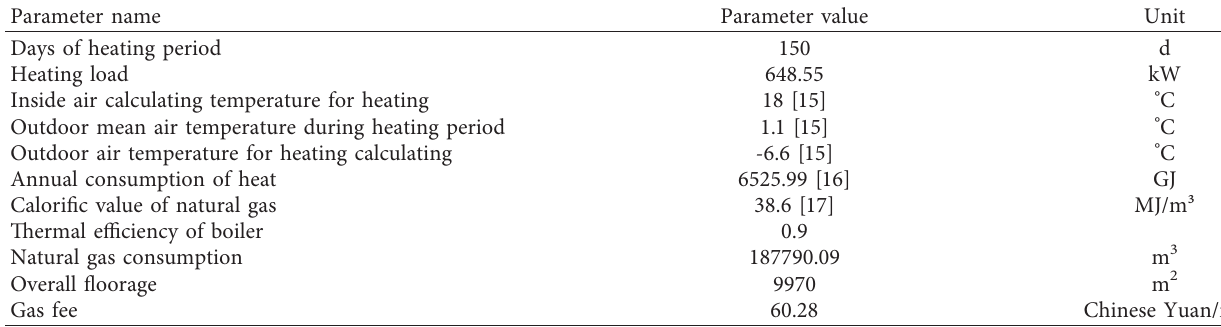
Table 2: Calculation of gas cost.